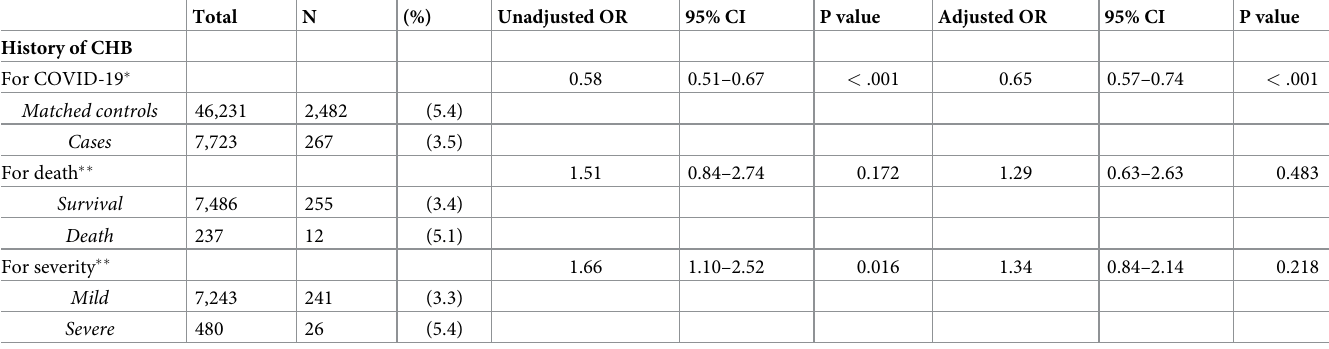
Table 2. Association between history of CHB and risk of COVID-19.